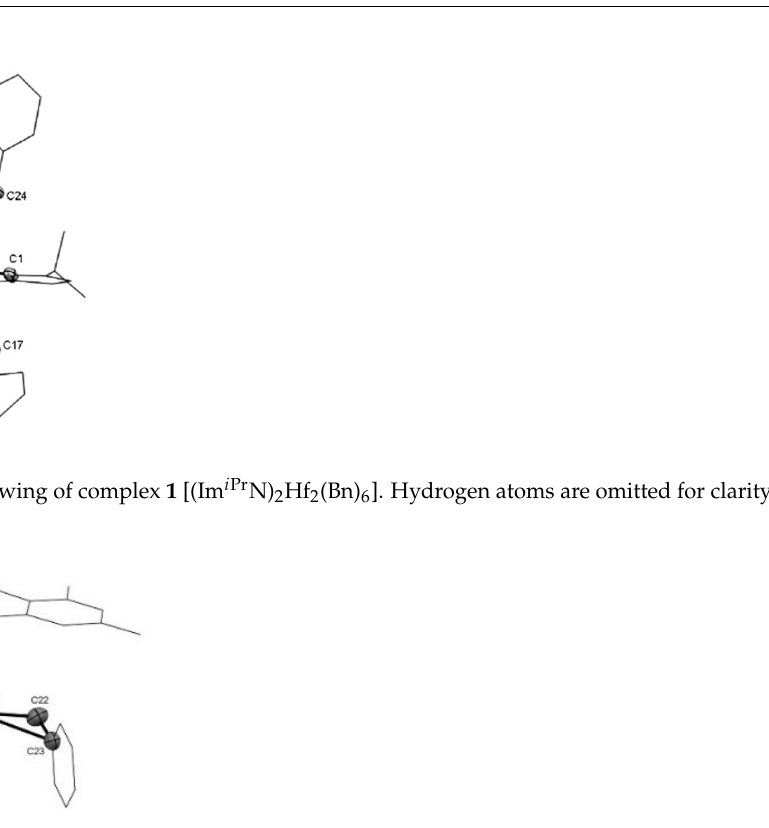
Figure 2. ORTEP drawing of complex 3 [(Im Mes N)Hf(Bn) 3 ]. Hydrogen atoms are omitted for clarity.